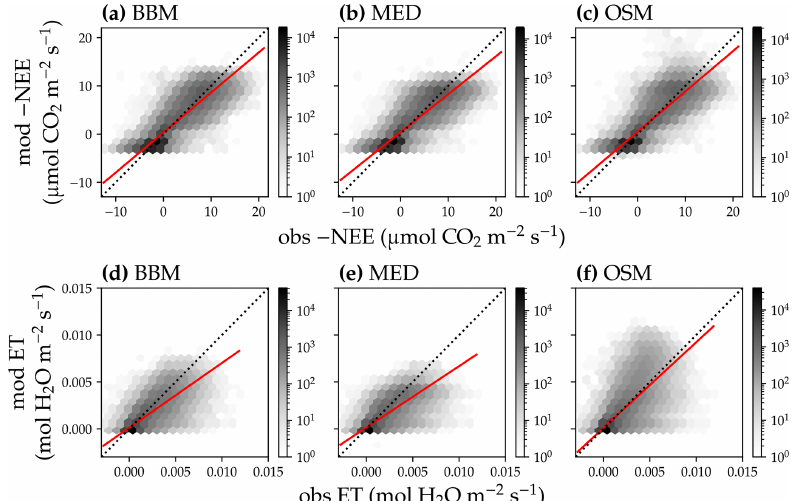
Figure 14. Comparison of modeled and observed carbon and water fluxes for the three stomatal models when fitting an extra empirical model stomatal model parameter for the US-NR1 (Niwot Ridge, evergreen gymnosperm forest) flux tower site. (a) Comparison of modeled ( y axis) and observed ( x axis) net ecosystem carbon flux (NEE) for the Ball et al. (1987) stomatal model (BBM). Shading represents density: the darker the hexagon, the more data that fell within the hexagon. The red solid line plots the linear regression of the data, and the black dotted line plots the 1 : 1 line. (b) Comparison of NEE for the Medlyn et al. (2011) model (MED). (c) Comparison of NEE for the Wang et al. (2020) model (OSM). (d) Comparison of ecosystem water flux (ET) for BBM. (e) Comparison of ET for MED. (f) Comparison of ET for OSM. This figure differs from Fig. 12 in that g 1 s (Eqs. 6, 7) for BBM and MED are also fitted.